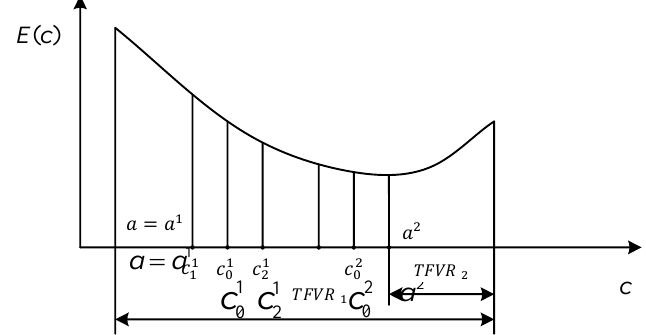
Fig. 4. The first two iterations of a one-dimensional unimodal function E ( c ) with a halving